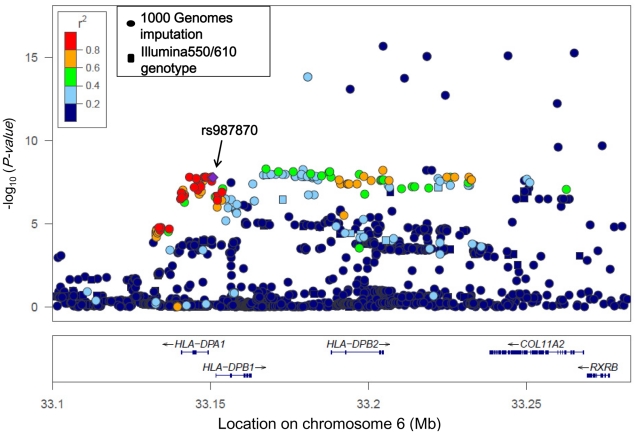
Association findings of genotyped (squares) and imputed (circles) SNPs in the HLA-DP region.SNP rs987870, which consistently showed an association with pediatric asthma in 3 independent populations, is located in the LD block between HLA-DPA1 and HLA-DPB1. The color intensity of each symbol reflects the extent of LD with rs987870: from red (r2>0.8) to blue (r2<0.2). The physical positions are based on NCBI build 36 of the human genome.